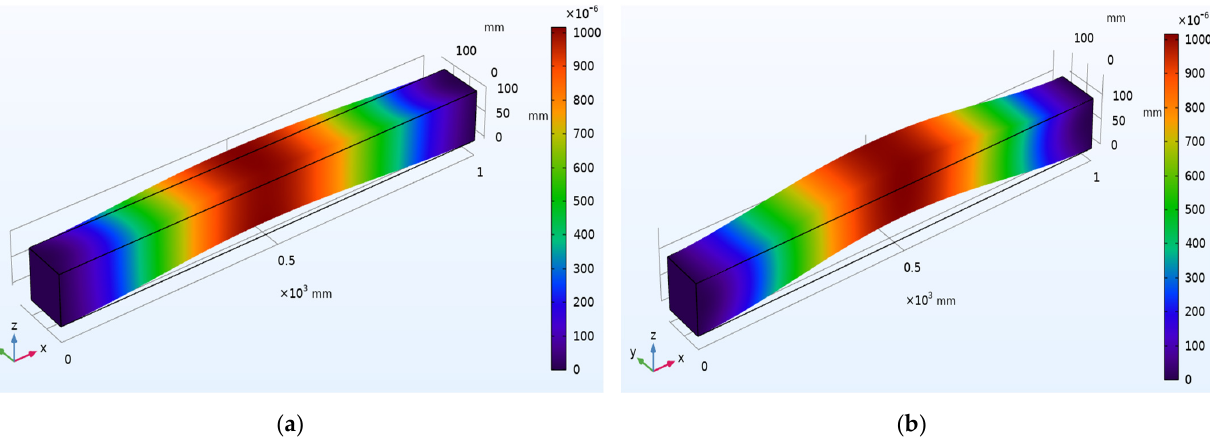
Figure 3. Surface displacement contours of beam for longitudinal mode shapes: ( a ) First mode; ( b ) Second mode.